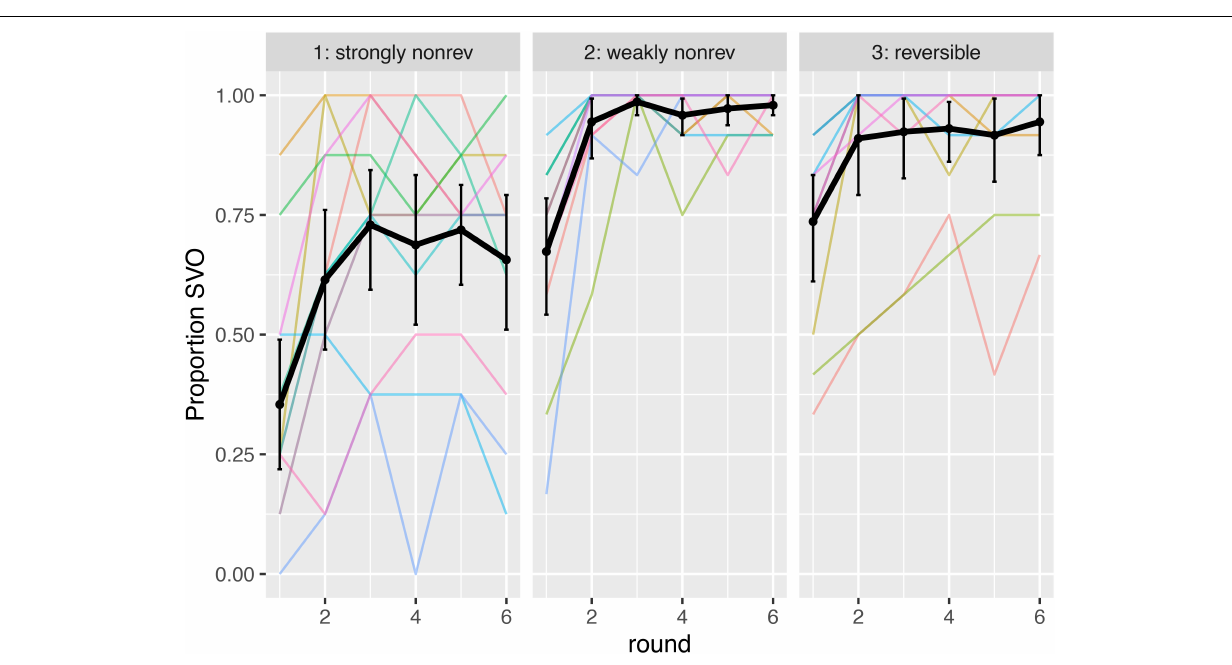
Over time, SVO became the most frequently used order by